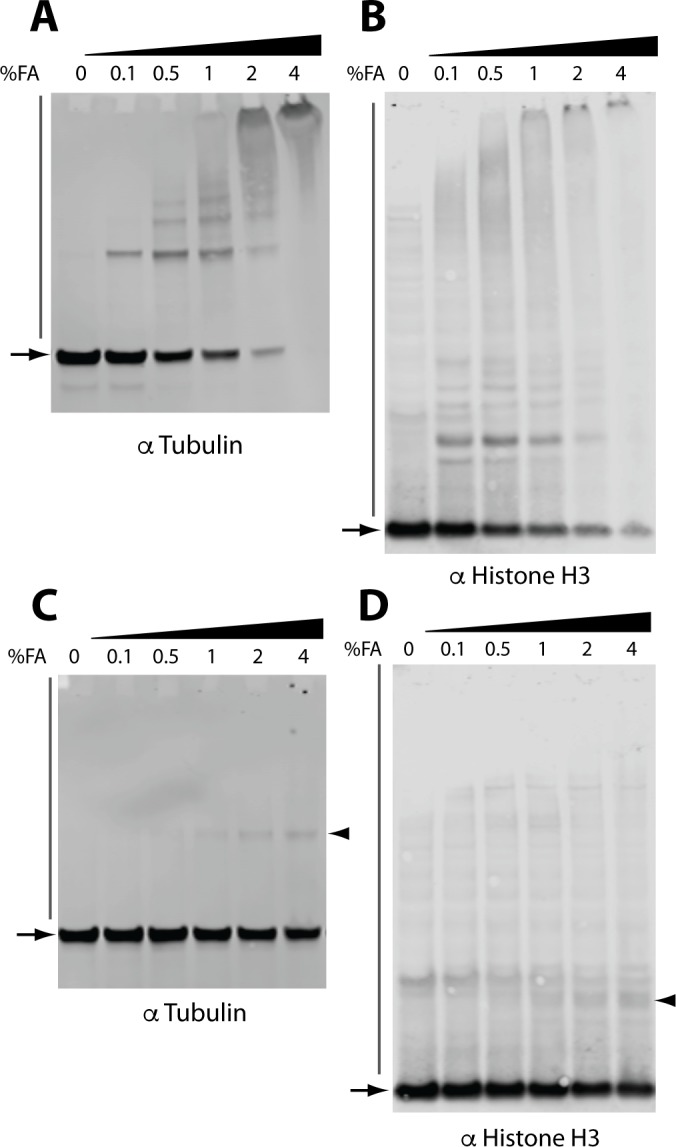
Immunoblot analysis of the effect of FA on the electrophoretic migration of individual proteins.Immunoblot analysis of crosslinked lysates for alpha tubulin (A) and histone H3 (B). Immunoblot analysis of crosslinked and reverse crosslinked lysates for alpha tubulin (C) and histone H3 (D). Arrowheads indicate high MW bands remaining after reverse crosslinking step that migrate at a higher MW than the expected monomer mass (arrows).